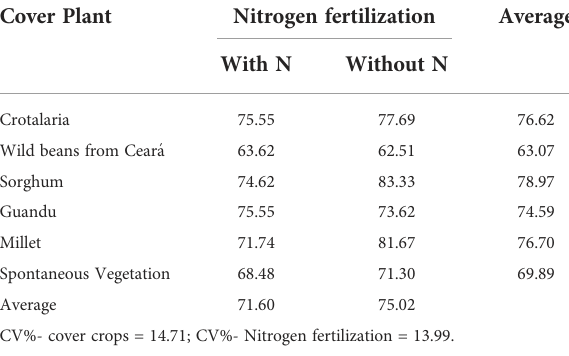
TABLE 3 Mycorrhizal colonization (%) of cover crops after corn cultivation, with and without Nitrogen fertilization in cover, in corn. Cover Plant